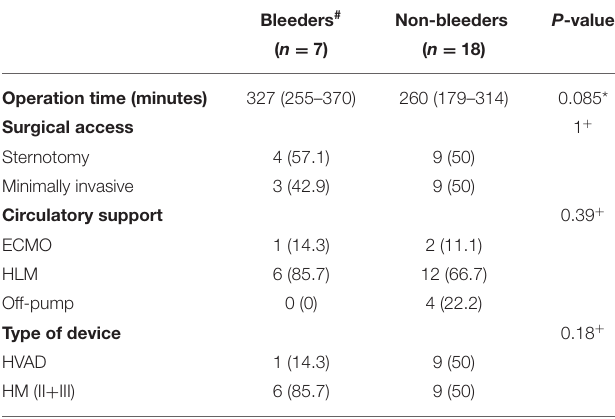
TABLE 2 | Intraoperative Data (referring to LVAD implantation).